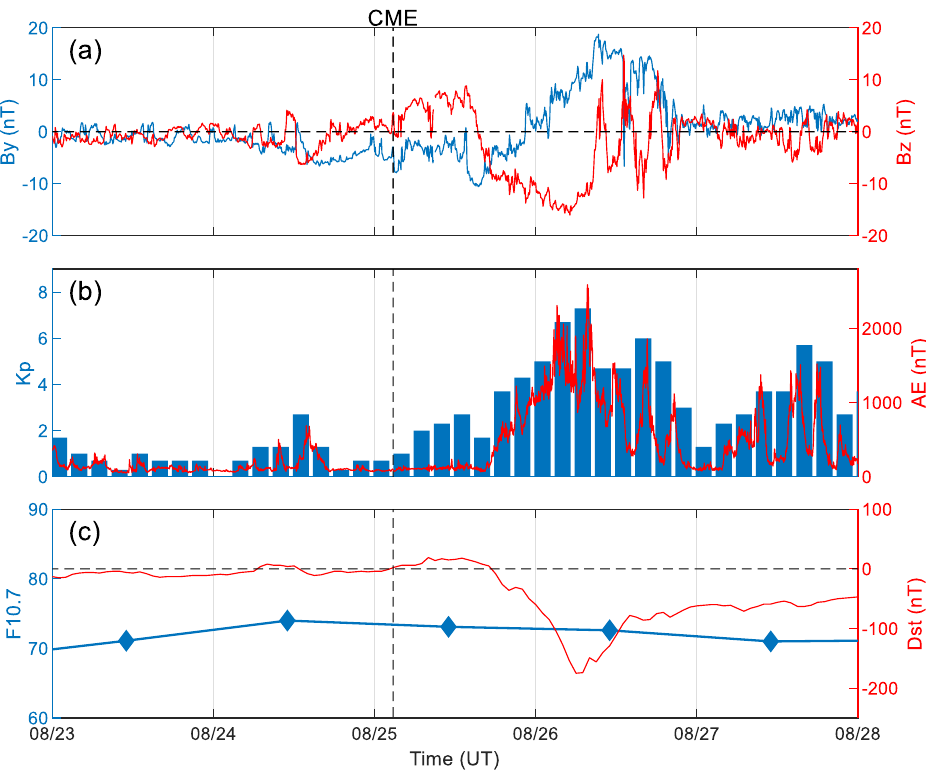
Figure 1. Geomagnetic conditions from 23 to 28 August in 2018. ( a ) IMF components of Bz and By in geocentric solar magnetospheric (GSM) coordinates. ( b ) the Auroral electrojet (AE) and Kp indices. ( c ) The F10.7 and Dst indices. The vertical black line denotes the arrival time of CME. The horizontal dashed line denotes zero value.